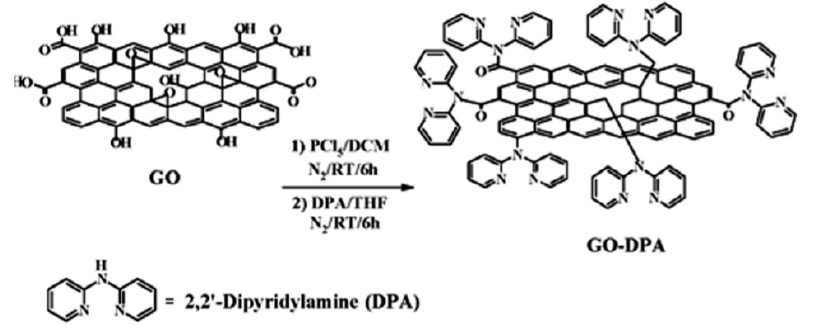
Figure 11. Synthesis Processes and Chemical Structure of GO-DPA (Reproduced or adapted from ref. [40], with permission from Royal Society of Chemistry, 2020).